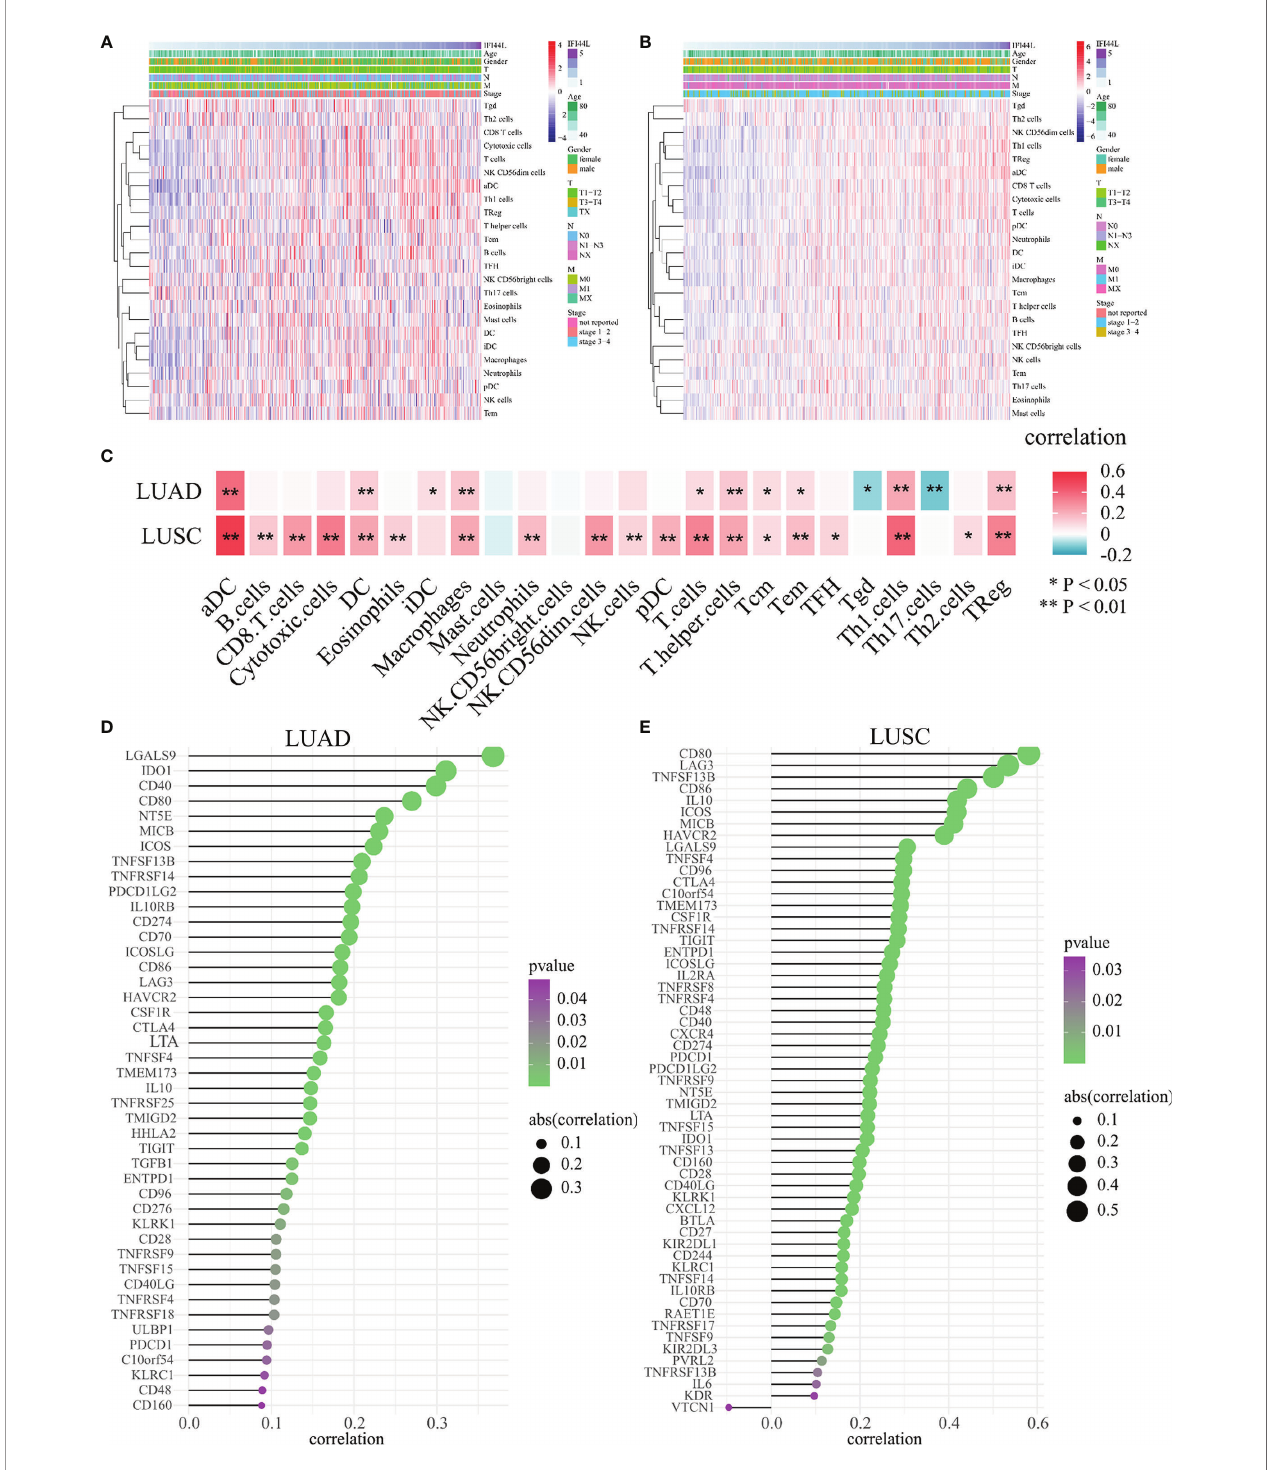
FIGURE 3 | Evaluation of the association between IFI44L transcription level with 24 TIICs and 70 immunomodulators in TCGA-NSCLC samples. (A, B) In fi ltration proportions of 24 TIICs were calculated by the ssGSEA method in each sample and presented by heatmap among TCGA-LUAD samples (A) and TCGA-LUSC samples (B) . (C) Correlation heatmap showed the signi fi cant relevance between IFI44L expression and 24 TIICs in TCGA-LUAD samples and TCGA-LUSC samples. (D, E) Identi fi cation and analysis of immunomodulators associated with the IFI44L gene in TCGA-LUAD samples (D) and TCGA-LUSC samples (E) . Immunomodulators that possess the statistically signi fi cant Spearman coef fi cients with IFI44L are shown in the graph. TIICs, tumor-in fi ltrating immune cells; TCGA, The Cancer Genome Atlas; LUAD, lung adenocarcinoma; LUSC, lung squamous cell carcinoma; * p < 0.05, ** p <